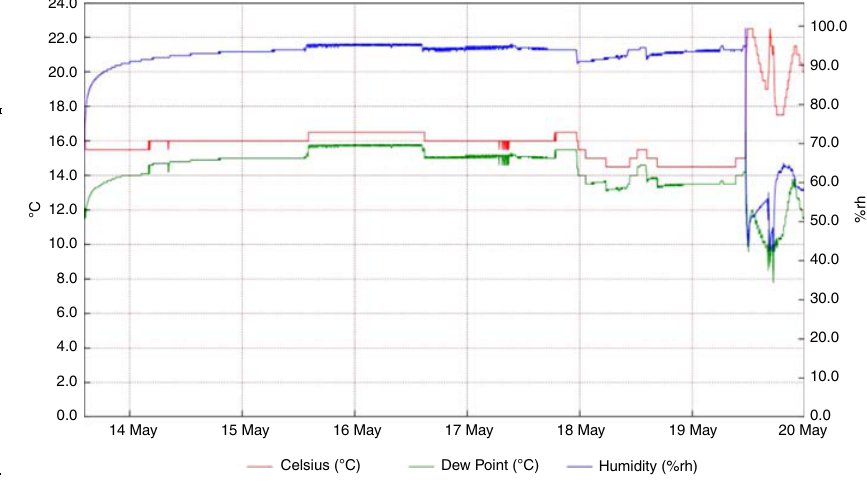
Figure A1. Temperature (°C), relative humidity (RH per cent) and dew point (°C) during the ripening of bananas